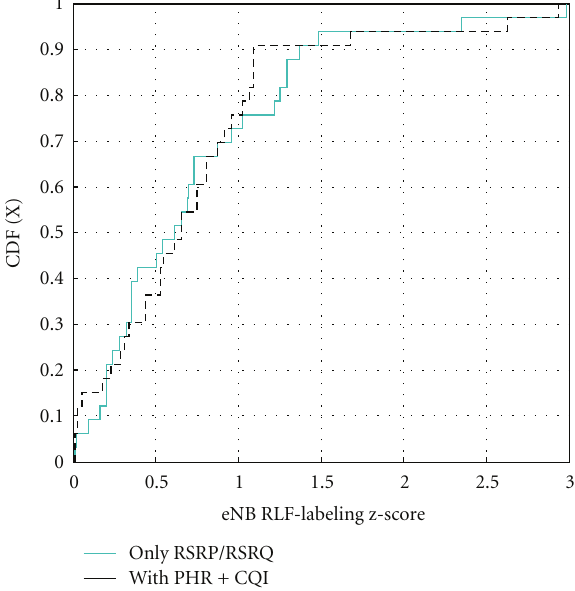
Figure 6: Standard-score distributions for reference simulation.